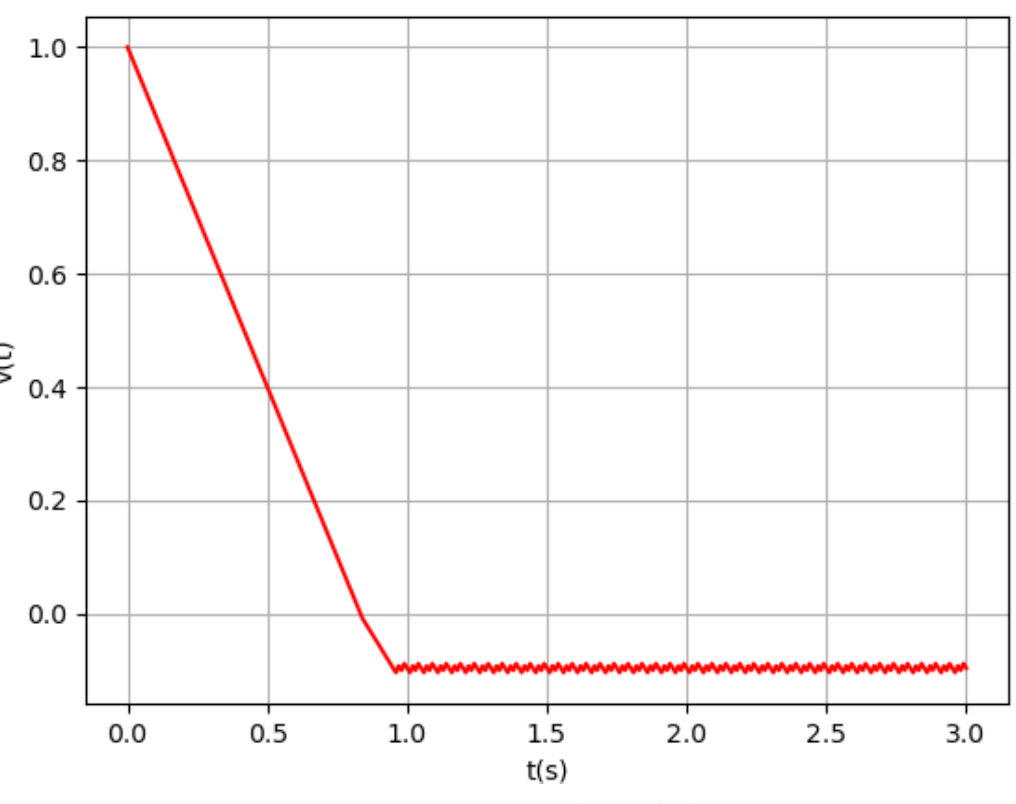
Figure 4. System output signal: perturbed case.